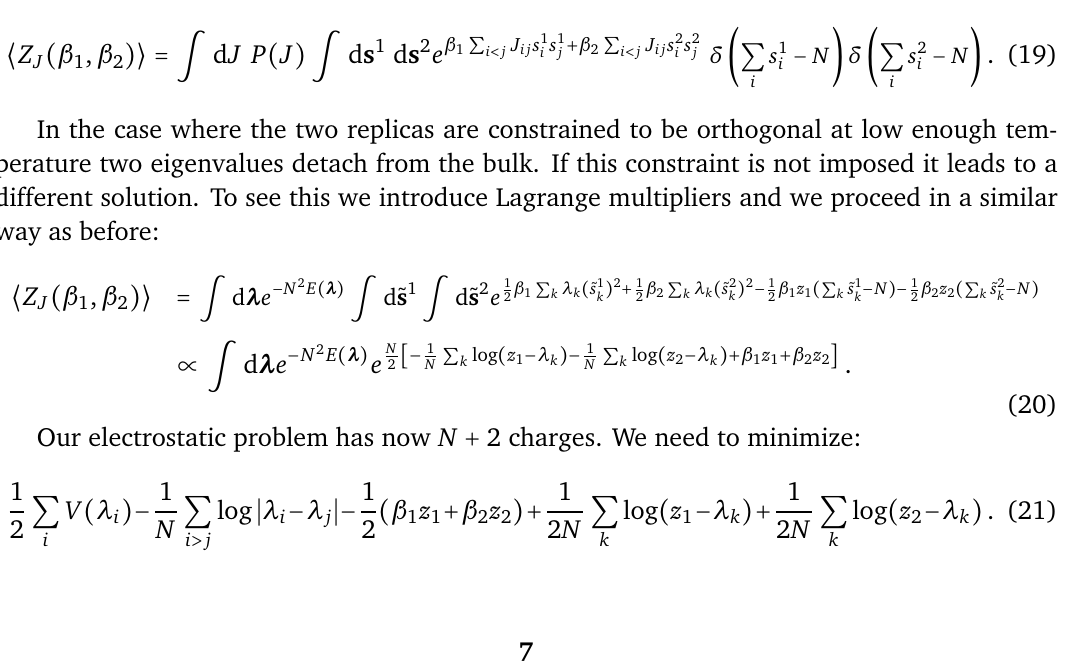
Figure 3: Stieltjes transform for the Gaussian ensemble S ± ( x ) = 1